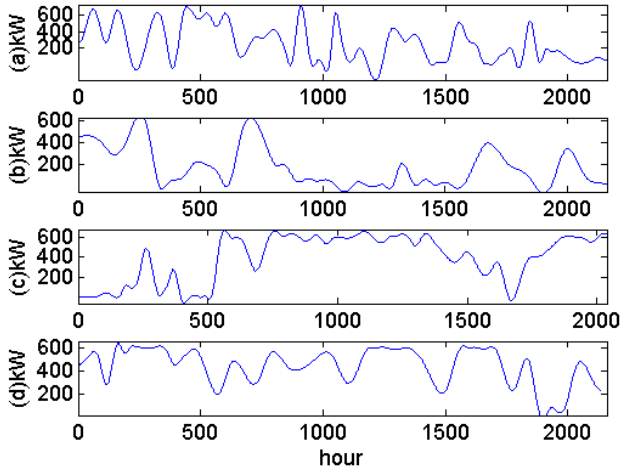
Figure 6. New residual functions of wind powers (kW) during the four seasons: ( a ) spring; ( b ) summer; ( c ) autumn; and ( d ) winter.